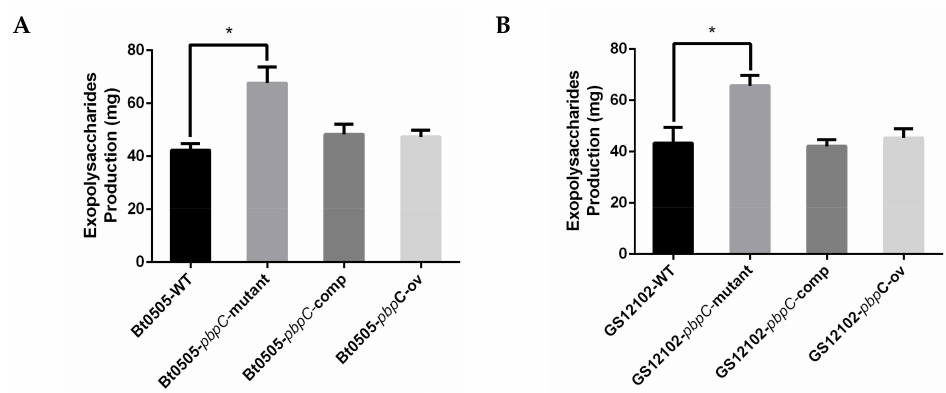
Figure 4. EPS production of wild-type, (cid:52) pbpC mutants, pbpC -comp, and pbpC -OE of Clavibacter michiganensis strains ( A ) BT0505 and ( B ) GS12102. Error bars represent standard error (n = 6). Asterisks (*) indicate significant differences ( p < 0.05).